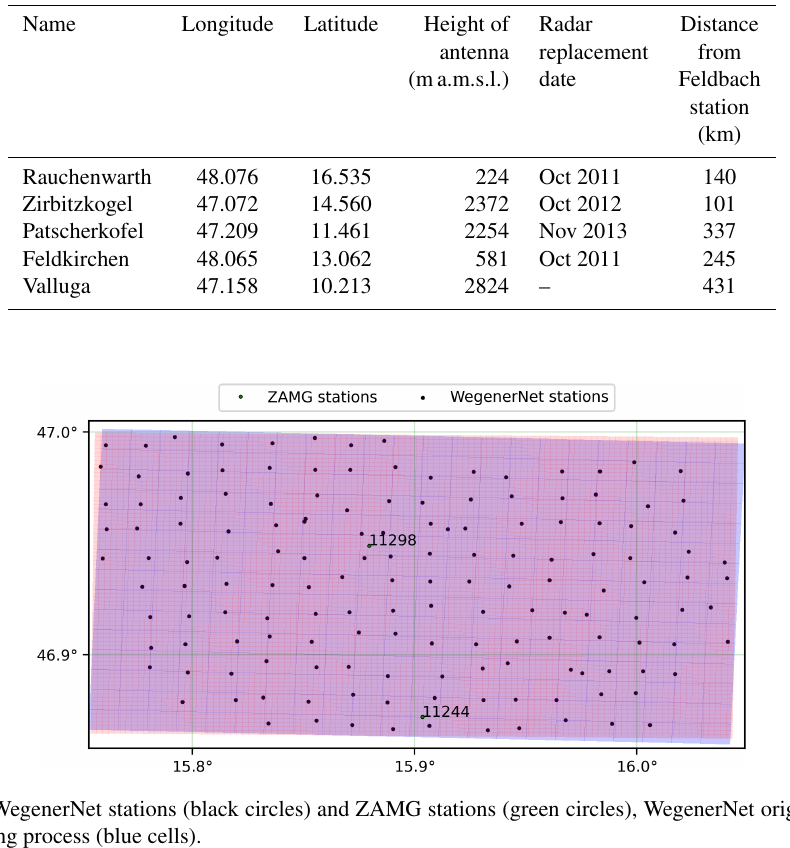
Table B1. Locations and distances of the Austrian radars from the Feldbach station (Station 11298).